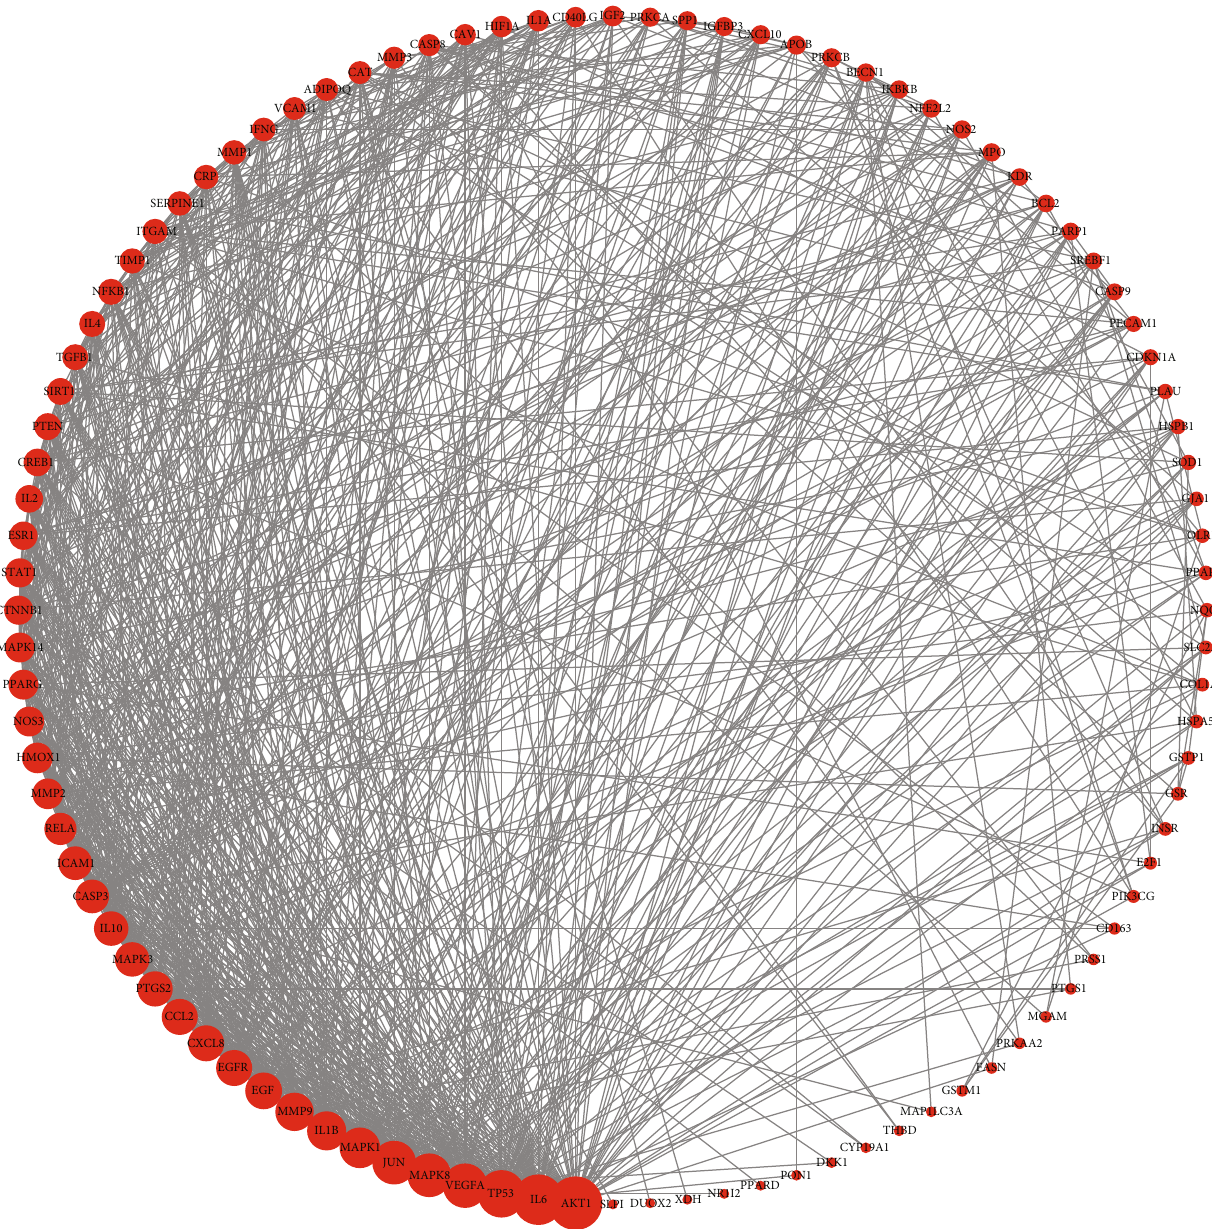
Figure 5: Protein-protein interaction networks were analyzed by Cytoscape software. The red circle represents 100 potential targets from the STRING data, the size of circle represents the degree, and the lines among inner nodes display the relationship between di ff erent